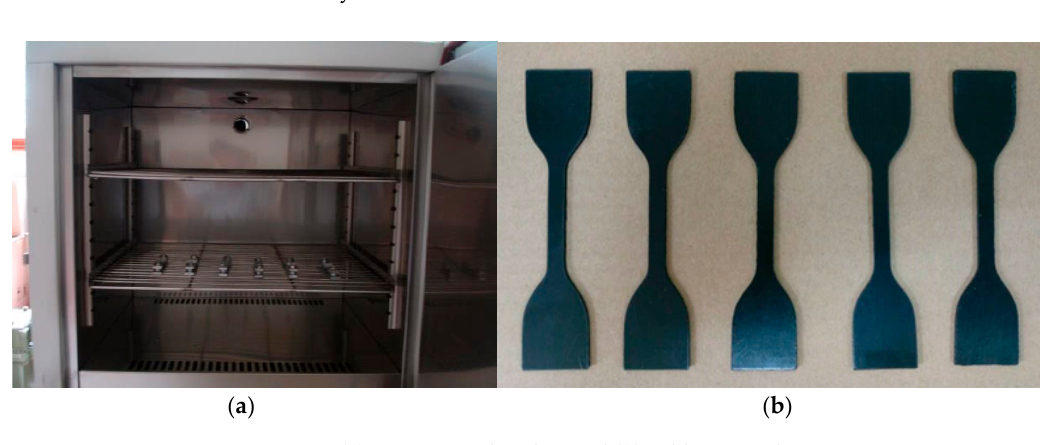
Figure 2. ( a ) Aging test chamber and ( b ) rubber samples.